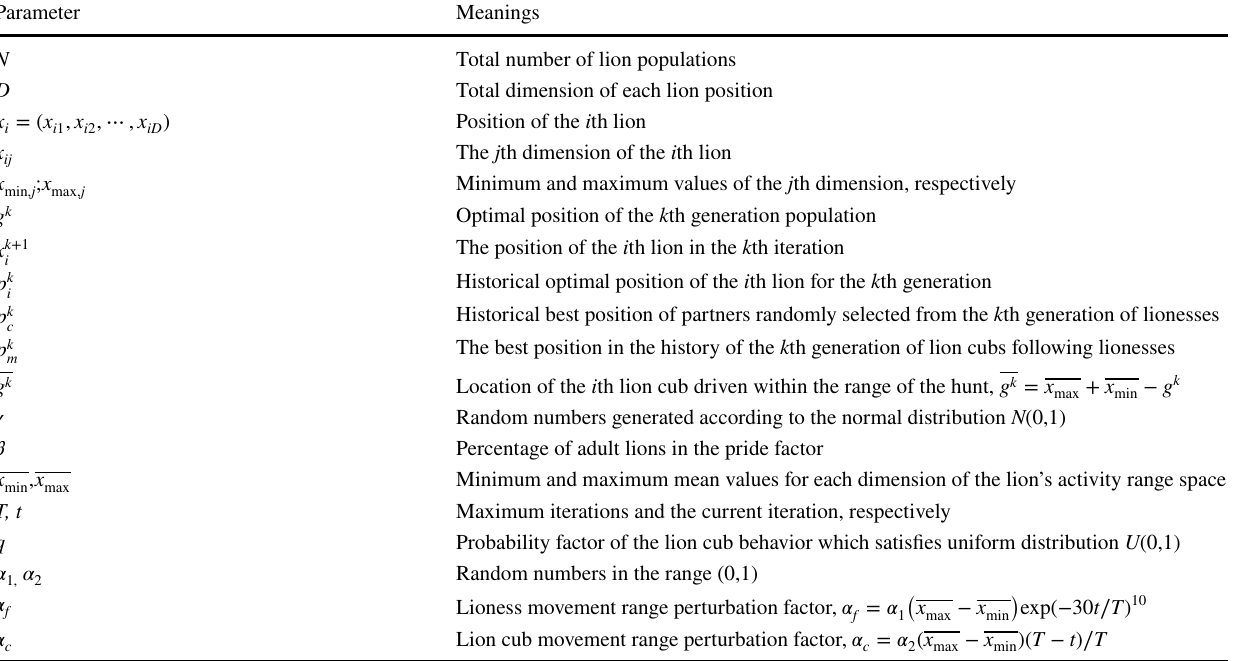
Table 1 Description of symbols involved in LSO and ACIE_LSO algorithms Parameter Meanings